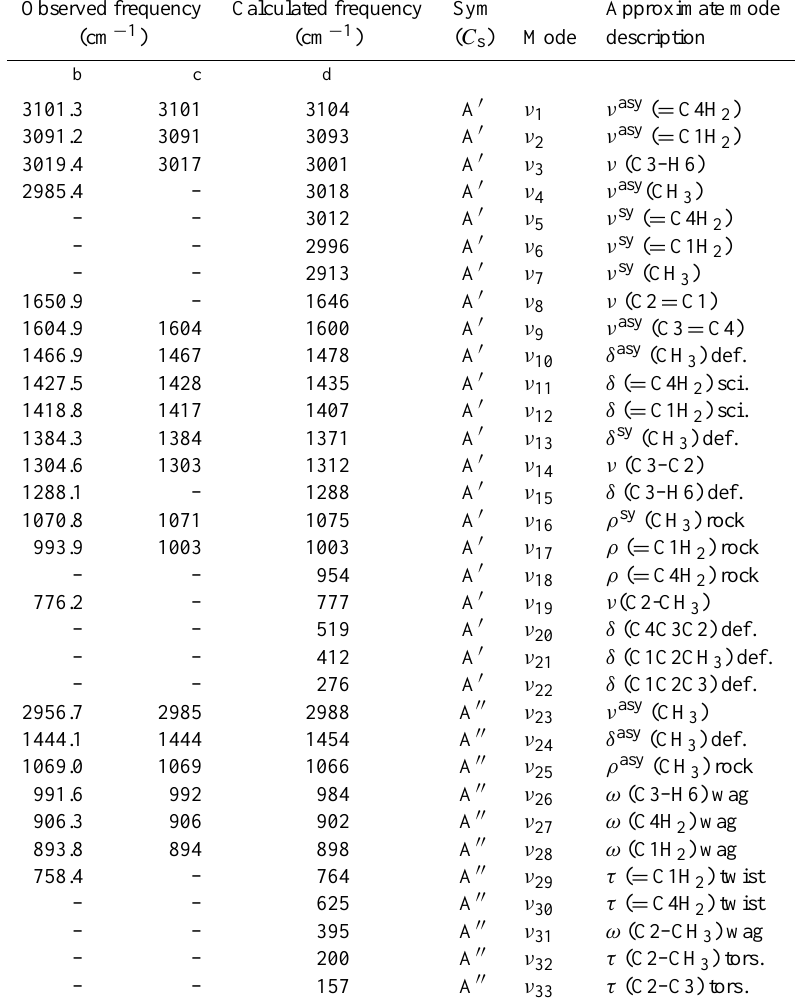
Table 4. Vapor-phase frequencies and vibrational assignments a for observed mid-infrared bands of the planar s- trans form of isoprene. Observed